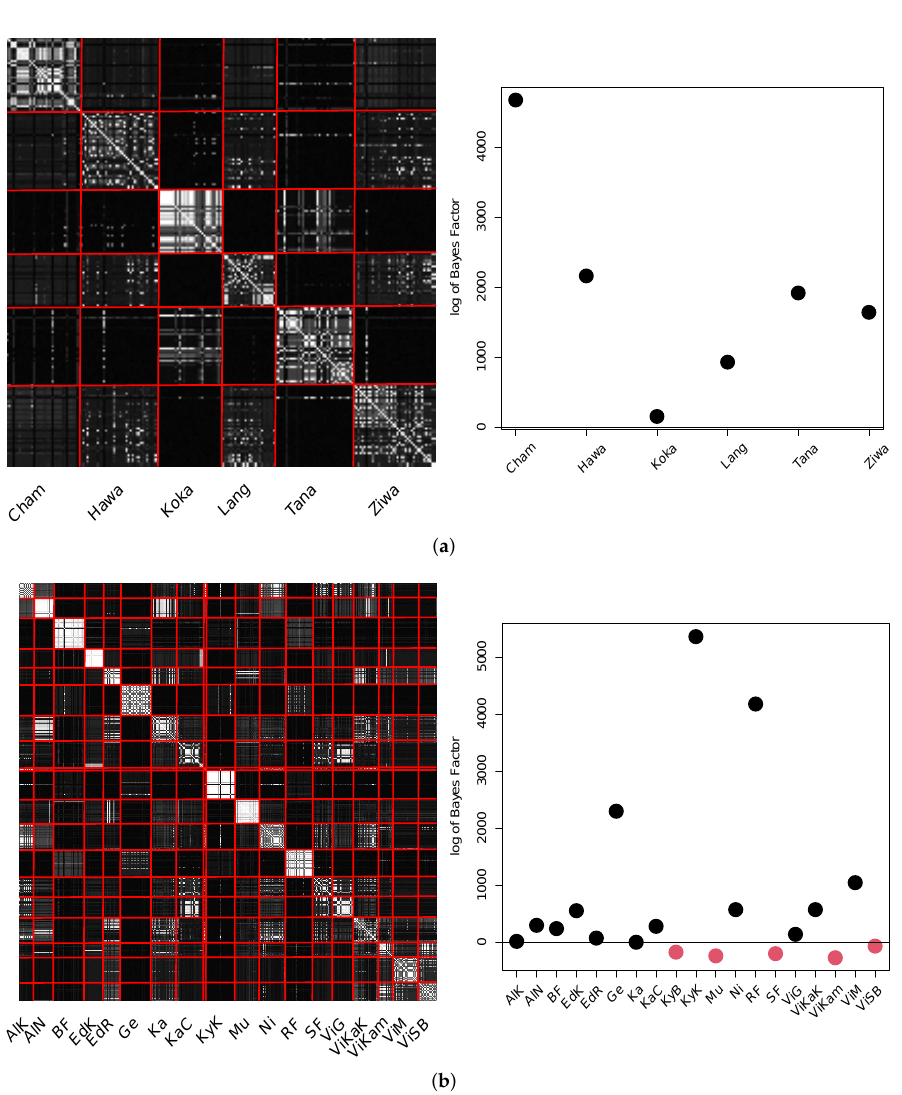
Figure 15. Visualization of the results obtained by pCA and the Bayes factor hypothesis test relying on cAE. Both pCA matrices show visible structure. All locations of Ethiopia were found to be significantly different. Fourteen out of nineteen locations were identified to be significantly different in Uganda’s locations. ( a ) pCA and Bayes factor results for Ethiopia relying on cAE. ( b ) pCA and Bayes factor results for Uganda relying on cAE. The KyB population label in the pCA matrix was removed due to